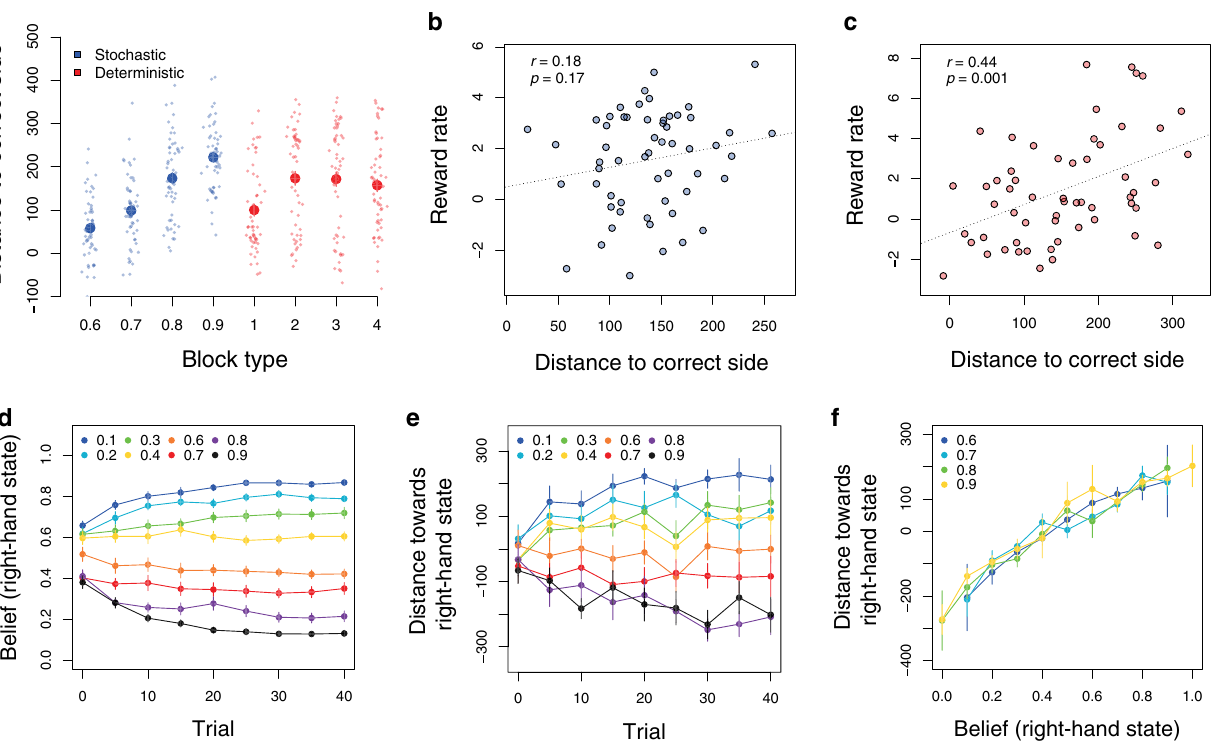
Fig. 4 Mouse-tracking results. a Distance towards the correct bottom fractal by condition and dif fi culty. b – c Correlation between reward rate and mouse- tracking measure of learning, split by condition: stochastic ( b ) and deterministic ( c ). d Stochastic task: evolution of the posterior Bayesian probability of revealing the bottom right-hand fractal, conditional on the top left-hand fractal choice, split by condition, for the fi rst 40 trials of each block (in bins of size 5). e Stochastic task: evolution of the mouse cursor towards the right-hand side of the screen, split by condition, for the fi rst 40 trials of each block (in bins of size 5). f Cursor distance as a function of Bayesian belief (in bins of size 0.1), by condition. All correlation plots show Pearson correlations, each individual point is one subject, and dotted lines indicate linear regression fi ts. In a – c : dots denote individual subjects, in all plots: error bars denote s.e.m. at the subject level ( N = 57). Source data are provided as a Source Data fi